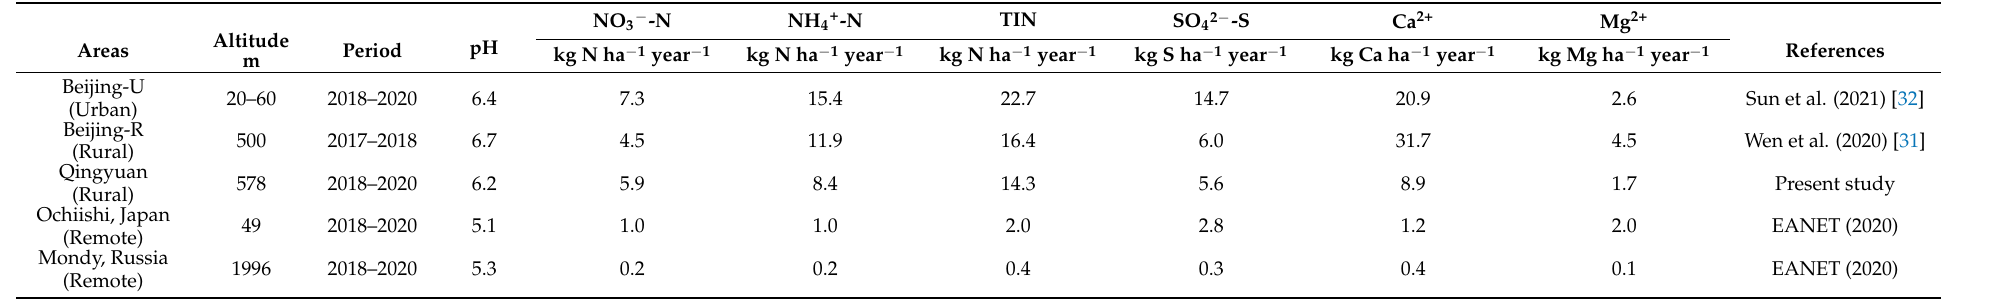
Table 1. The annual deposition of inorganic NO 3 − -N, NH 4+ -N, total inorganic N (TIN), SO 42 − -S, Ca 2+ , and Mg 2+ and the volume-weighted mean pH in precipitation in the Qingyuan forest, compared with another four representative sites with comparable latitudes. Areas